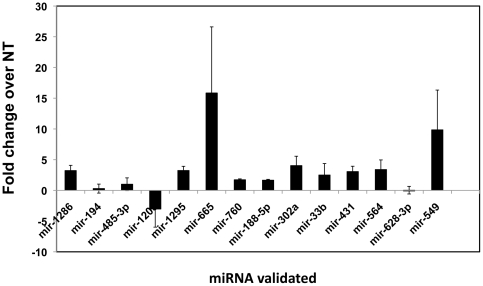
Quantitative real time RCR (qRT-PCR) confirmation of randomly selected miRNAs from the microarray analysis.The expression of selected miRNAs in PBMCs infected with HIV-1 along with the expression of uninfected controls were tested for validation by qRT-PCR using a specific primer and probe for each miRNA. Fold increase/decrease was calculated based on endogenous control normalization. Average fold change for each miRNA represents fold change obtained from 10 independent donors.